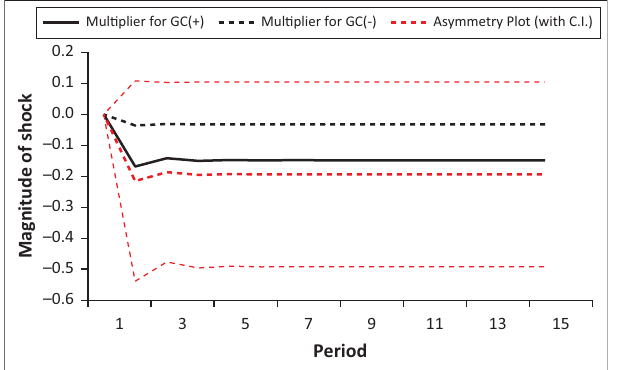
FIGURE 2: Dynamic multiplier, government consumption expenditure on household